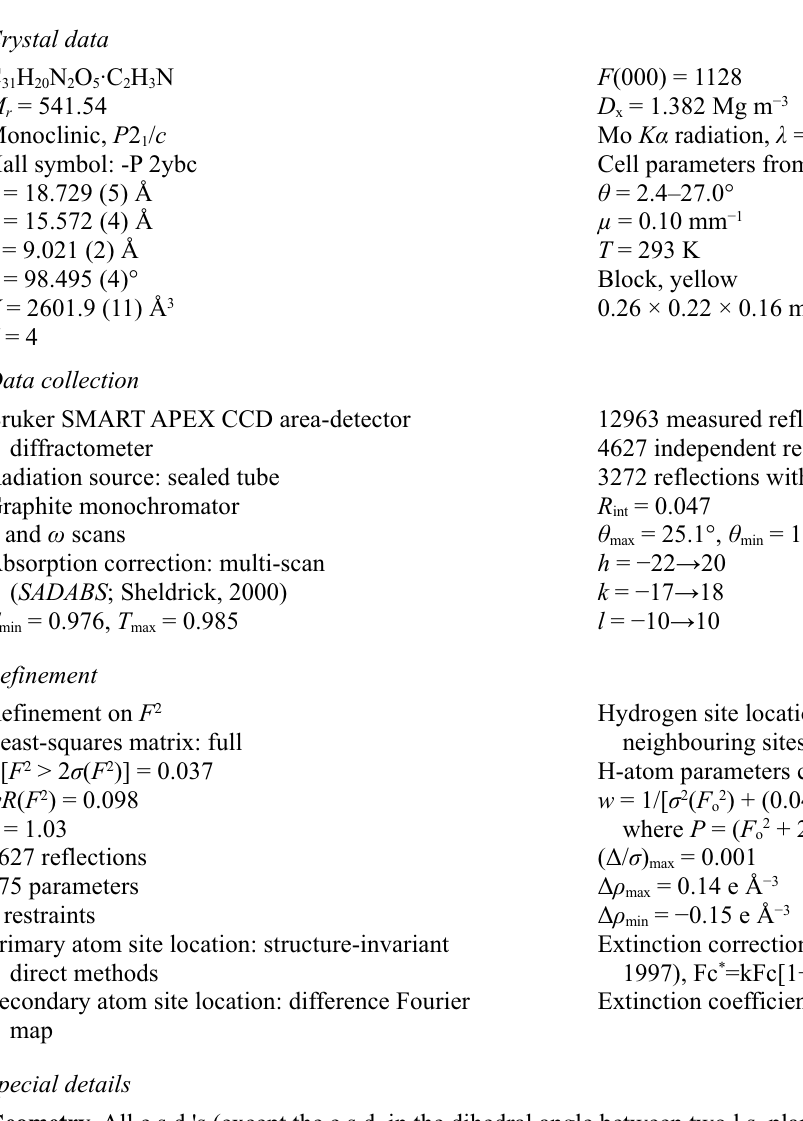
Figure 2 A packing diagram for (I). Hydrogen bonds are shown as dashed